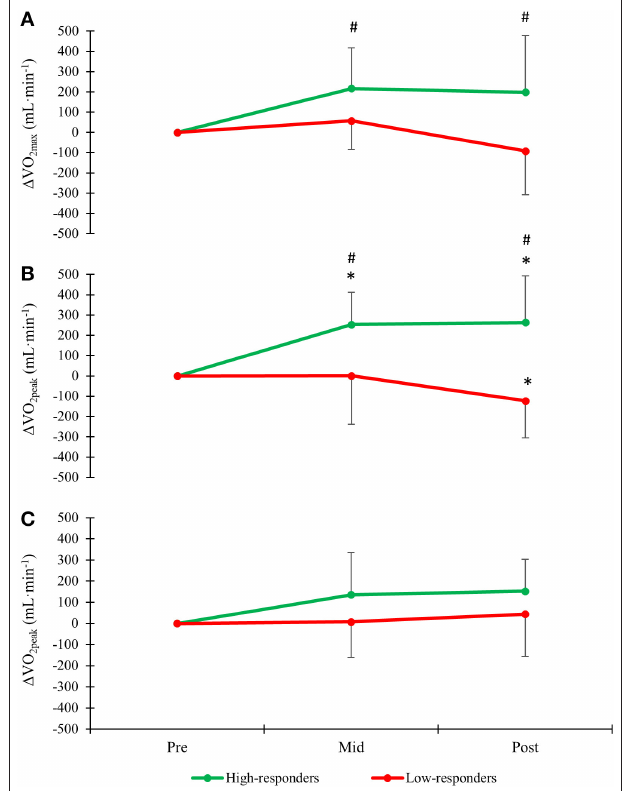
FIGURE 2 | Changes in (A) VO 2max treadmill running and (B) VO 2peak treadmill roller-ski skating and (C) VO 2peak double-poling ergometry in high- and low-responders following a 6-month XC-ski specific training period. *Significant pre- to post change within groups ( P ≤ 0.05) # Significant difference in pre- to post change between groups ( P ≤ 0.05).